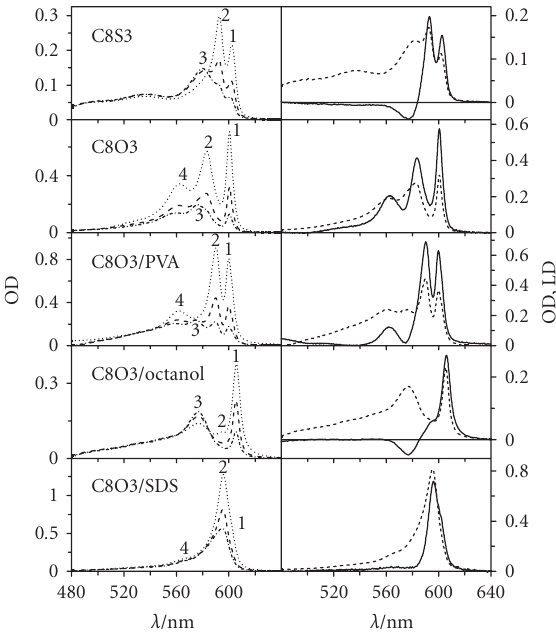
Figure 2: Polarized absorption and linear dichroism spectra of var- ious TBC-based aggregates. The left panels show the absorption spectra measured with light polarized parallel (dotted line) and per- pendicular (dash-dotted line) to the flow direction; the dashed line shows the isotropic spectrum. The absorption bands are numbered from 1 to 4 starting at low-energy side. The right panels show the corresponding linear dichroism spectra (solid line), together with the isotropic absorption spectrum (dashed line) for